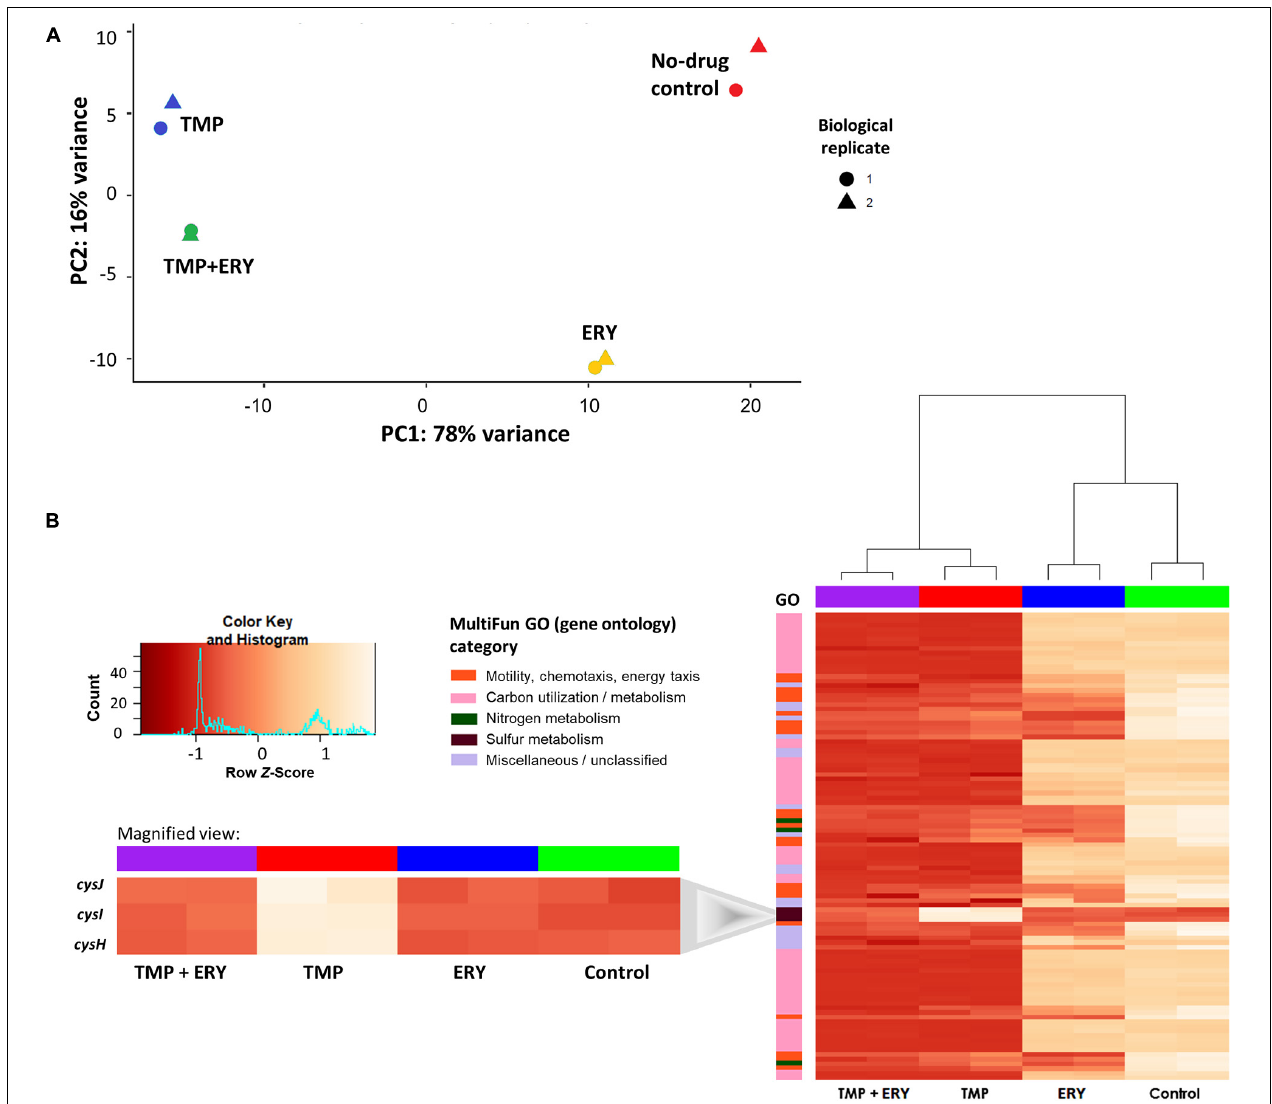
FIGURE 2 | In TMP + ERY combination treatment, TMP exerts a much stronger overall effect on the transcriptomic response than ERY does. (A) TMP triggers a different transcriptomic response than ERY but is similar to the combination treatment of TMP + ERY. Principal component 1 (PC1) explains 78% of the total variance in gene expression, while PC2 accounts for 16%. TMP (blue) and ERY (yellow) trigger different transcriptomic responses, and the response to TMP + ERY treatment (green) is more similar to TMP than it is to ERY. (B) Except for three sulfur metabolism related genes, TMP and TMP + ERY show a high degree of similarity in gene expression profiles. Normalized gene counts from RNA-Seq were Z -score transformed across all sample groups before a two-way hierarchical clustering analysis was performed based on the top 100 genes with the highest variance. The heatmap revealed that the transcriptomic responses for the TMP and TMP + ERY groups were highly similar across four MultiFun gene ontology (GO) categories for 97 genes. The only exception is the sulfur metabolism category in which cysH and the cysIJ operon do not display TMP-induced upregulation in the TMP + ERY group